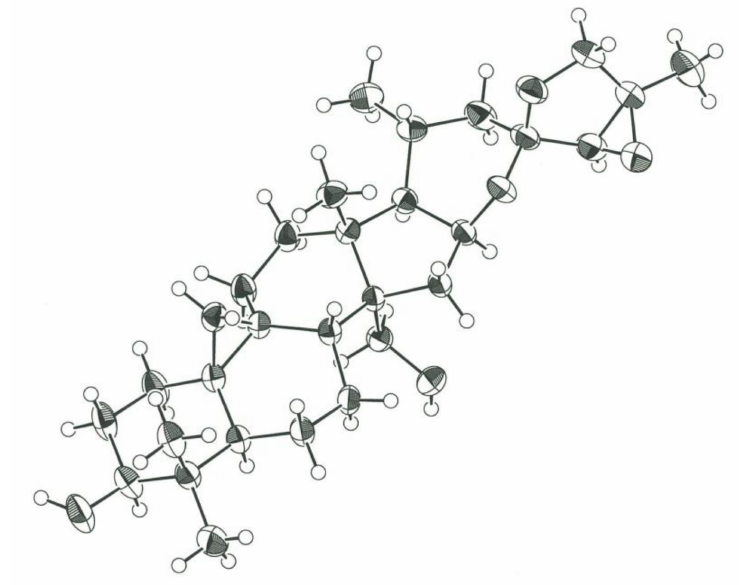
Figure 2. Perspective drawing of